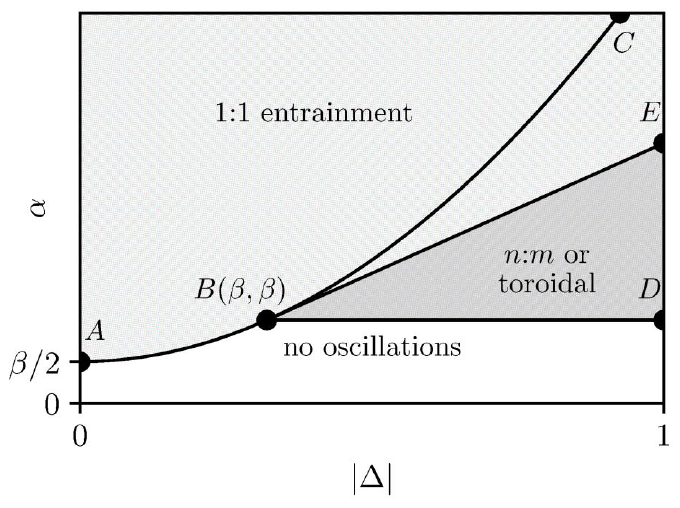
Figure 3. Bifurcation diagram and regions of oscillation. Curve ABC: Hopf bifurcation, curve BE: a ¼ 3 = 2, saddle-node bifurcation between limit cycles, line BD: double Hopf bifurcation [18].